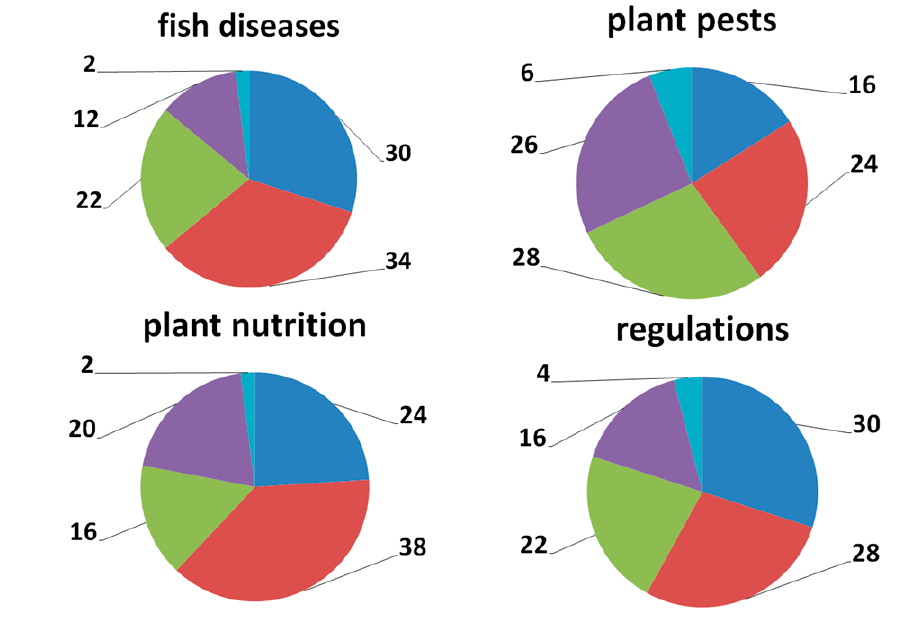
Figure 4. Opinions of respondents (expressed as the percentage of total answers), regarding the degree to which they agreed with a statement about their knowledge about fish diseases, plant pests, plant nutrition, and regulations for fish processing (see question 25 in Supplementary Materials).